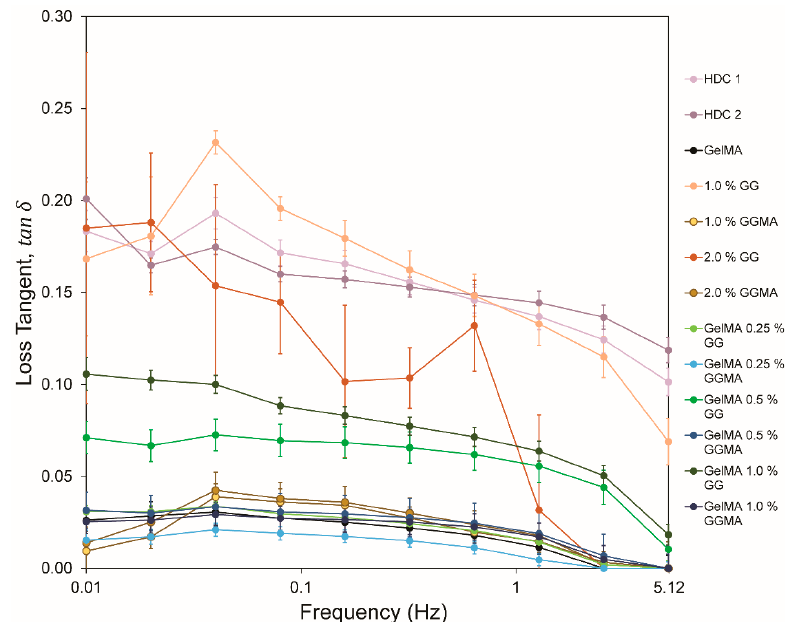
Figure 6. Loss tangent as a function of frequency of all mechanically tested groups. Data is presented on a logarithmic scale for frequency (Hz) and on a linear scale loss tangent ( tanδ ). Values are presented as mean of n = 5 samples with error bars indicating standard error of the mean.